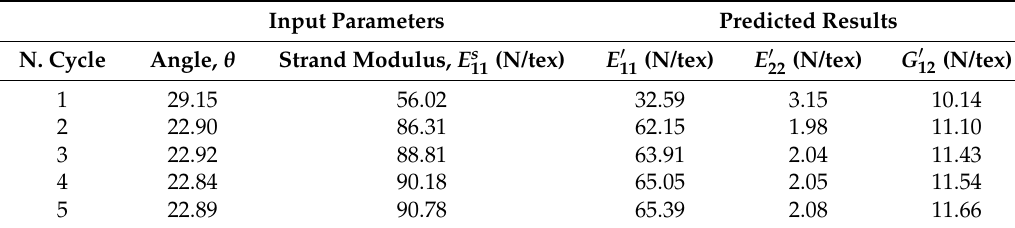
Figure 11. Braided angle vs. strain and its curve fitting at the first cycle. Table 5. Input parameters and estimated results of specific modulus.